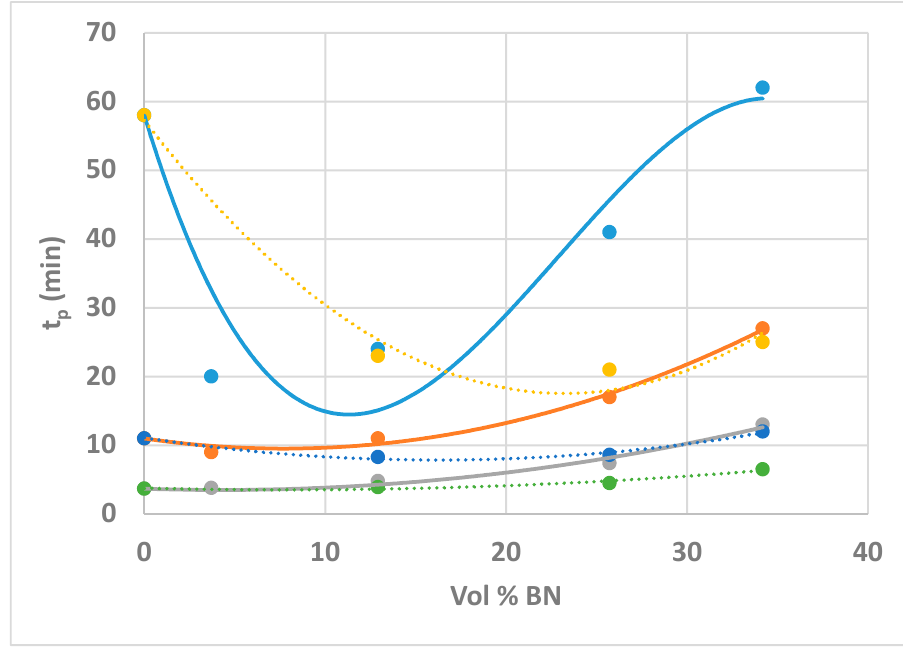
Figure 5. Plot of t p as a function of vol % BN for the systems ETLBN80 and ETLBN6, respectively, at the isothermal cure temperatures of 60 °C (dark blue, purple), 70 °C (red, light blue), and 80 °C (green, orange). The curves are drawn to guide the eye: full lines for ETLBN80, dotted lines for ETLBN6. Table 3. Results for ETLBN80 system from isothermal DSC cure experiments at different cure temperatures, T c : Δ H , T g ∞ , t p .